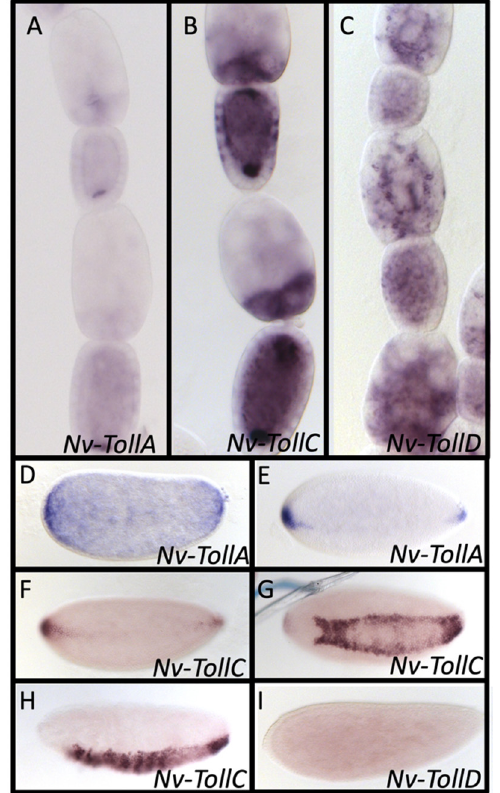
Figure 5. mRNA expression of Toll paralogs in N. vitrpennis ovarioles and embryos. ( A – D ) Egg chambers at mid to late oogenesis shown. ( A ) Nv-TollA is localized posteriorly in the oocyte. ( B ) Nv- TollC is strongly enriched at both the anterior and posterior poles of the oocyte and has elevated expression in the posterior of the nurse cells. ( C ) Nv-TollD is ubiquitously expressed in the oocyte and nurse cells. ( D – E ) Nv-TollA is initially ubiquitously expressed, with elevated expression at the anterior and posterior ends in the very early blastoderm stage ( D ). Expression then becomes restricted to just the pole, before expanding along the ventral midline in mid to late blastoderm stages ( E ). ( F – H ) Nv-TollC is initially expressed at the anterior and posterior poles at mid blastoderm before elongating along the ventral midline in the late blastoderm ( F ). The stripe later outlines the mesoderm–ectoderm border ( G ). Expression expands ventrally filling in the presumptive mesoderm at gastrulation ( H ). ( l ) Nv-TollD is expressed ubiquitously at low levels (mid blastoderm stage shown).